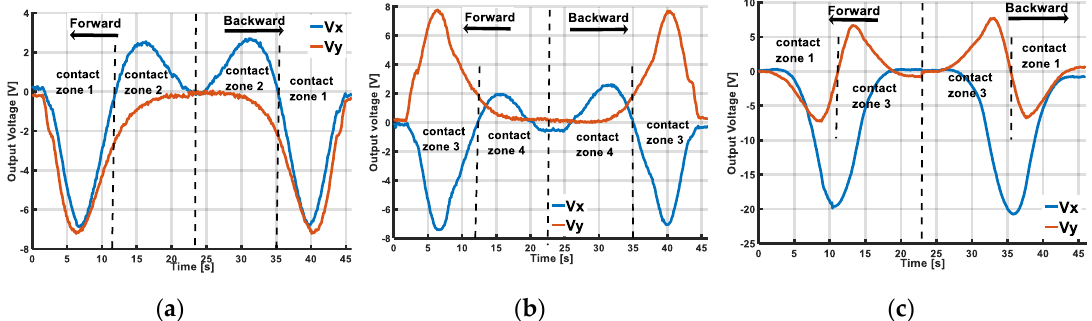
Figure 14. Output voltage 𝑉 𝑥 , 𝑉 𝑦 of accelerometer with different sliding cases. 𝑉 𝑥 , 𝑉 𝑦 values depend on contact zone between indenter and skin’s surface. Based on changed behaviour of 𝑉 𝑥 , 𝑉 𝑦 , our sensing system can temporally detect sliding directions: forward and backward in both X- and Y-sliding cases.